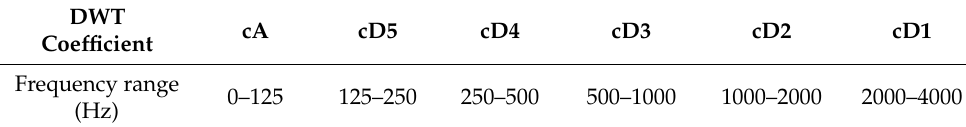
Table 2. Frequency range of DWT coefficients for db6 wavelet and f s = 8 kHz.